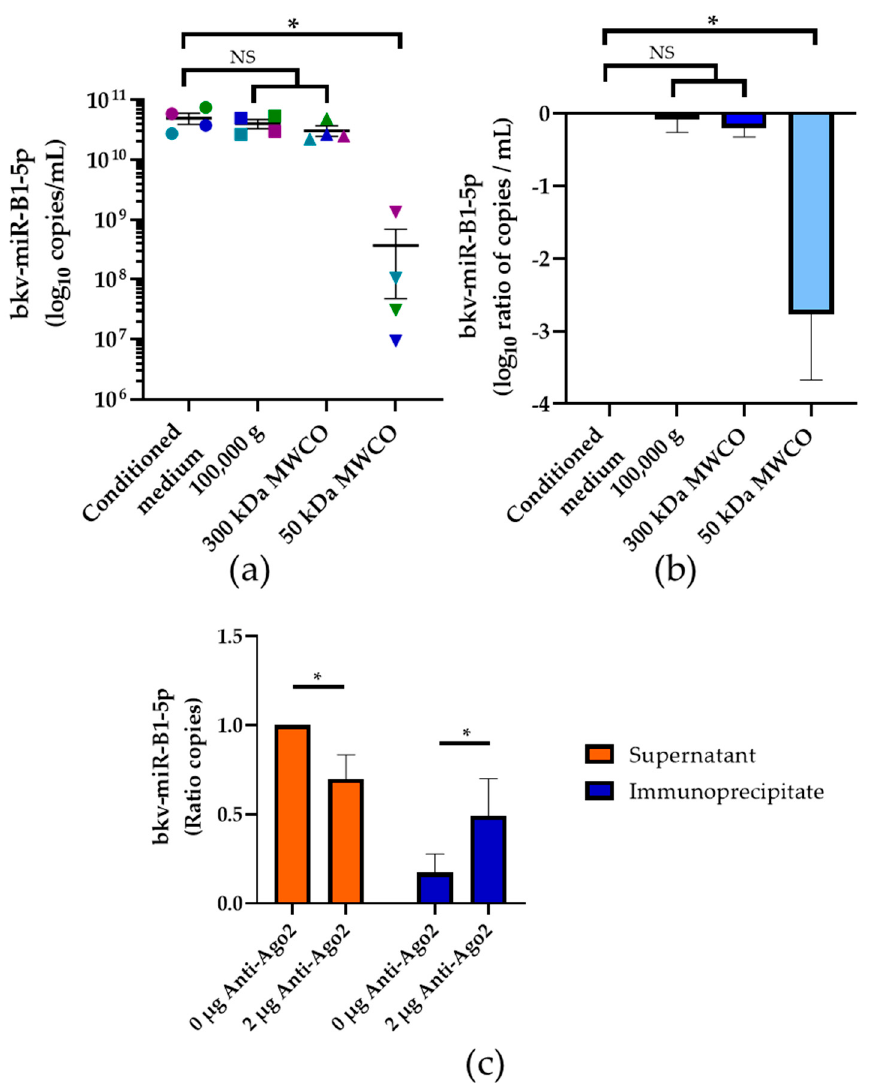
Figure 4. bkv-miR-B1-5p level ( a ) and log10 ratio ( b ) in conditioned medium from BKPyV-infected Vero cells, supernatants obtained after centrifugation at 100,000 × g for 2 h at 4 ◦ C, and filtrates obtained after filtration through 300 kDa and 50 kDa MWCO membranes. Lines ( a ) and colored bars ( b ) represent mean, and error bars represent the standard deviation of four independent experiments. Paired samples are color-matched; ( c ) Ratio of bkv-miR-B1-5p amount in anti-Ago2 and control supernatant (orange) and immunoprecipitate (blue). Colored bars represent mean and error bars represent the standard deviation of 4 independent experiments. Pairs of samples are color-matched. p values were obtained by a Mann-Whitney test (*: p < 0.05).